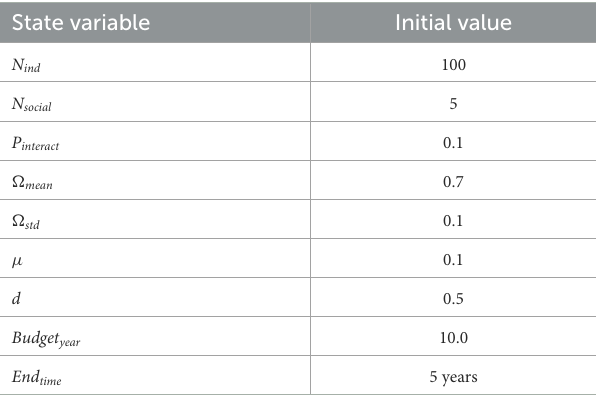
TABLE 3 Parameters that determine the action of the Institution agent at time step t .